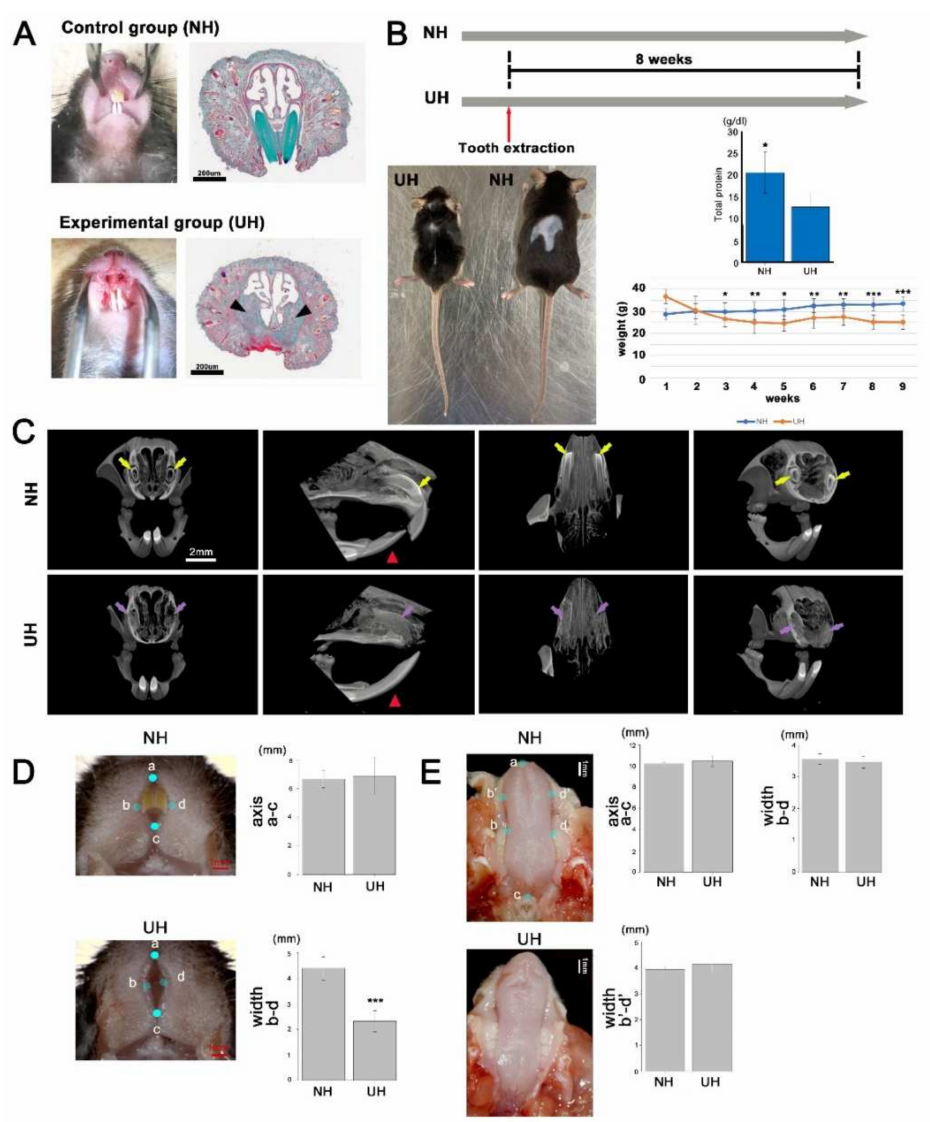
Figure 2. The establishment of incisor-deficient mice: ( A ) Before or after anterior tooth extraction. After tooth extraction, new bone formation was identified in the extraction sockets (arrowheads). ( B ) Physical description of the tooth loss (UH) and non-extraction control groups (NH). Body size was smaller in the UH group than in the NH group. Body weight was significantly lower in the UH group than in the NH group (* p < 0.05, ** p < 0.01, *** p < 0.01). The total protein expression was lower in the UH group than in the NH group (* p < 0.05). ( C ) Micro-computed tomography. Upper incisors were identified in the tooth socket (yellow arrows). New bone formation was identified in the extraction sockets (purple arrows). The lower incisor tooth was extended in UH mice compared with NH mice (red arrowheads). ( D , E ) Alteration of the lip and tongue morphology after tooth loss. The width of the area between the upper and lower lips was significantly different between the NH and UH groups (* p < 0.05), but there was no change in the major axis of the area between the groups. The width and major axis of the tongue did not differ between the